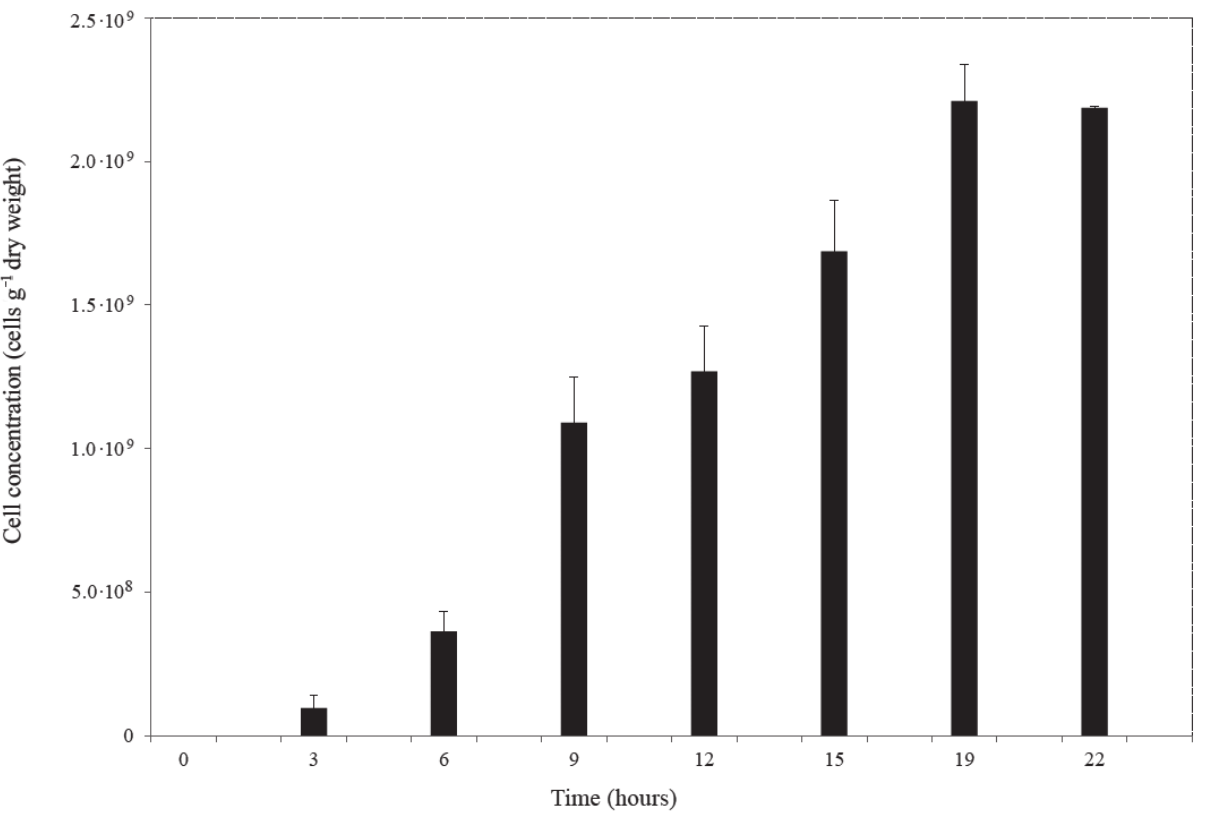
Fig. 3 – Concentration of yeast cells attached to the support material during cultivation in 12°Plato laboratory malt wort at 25